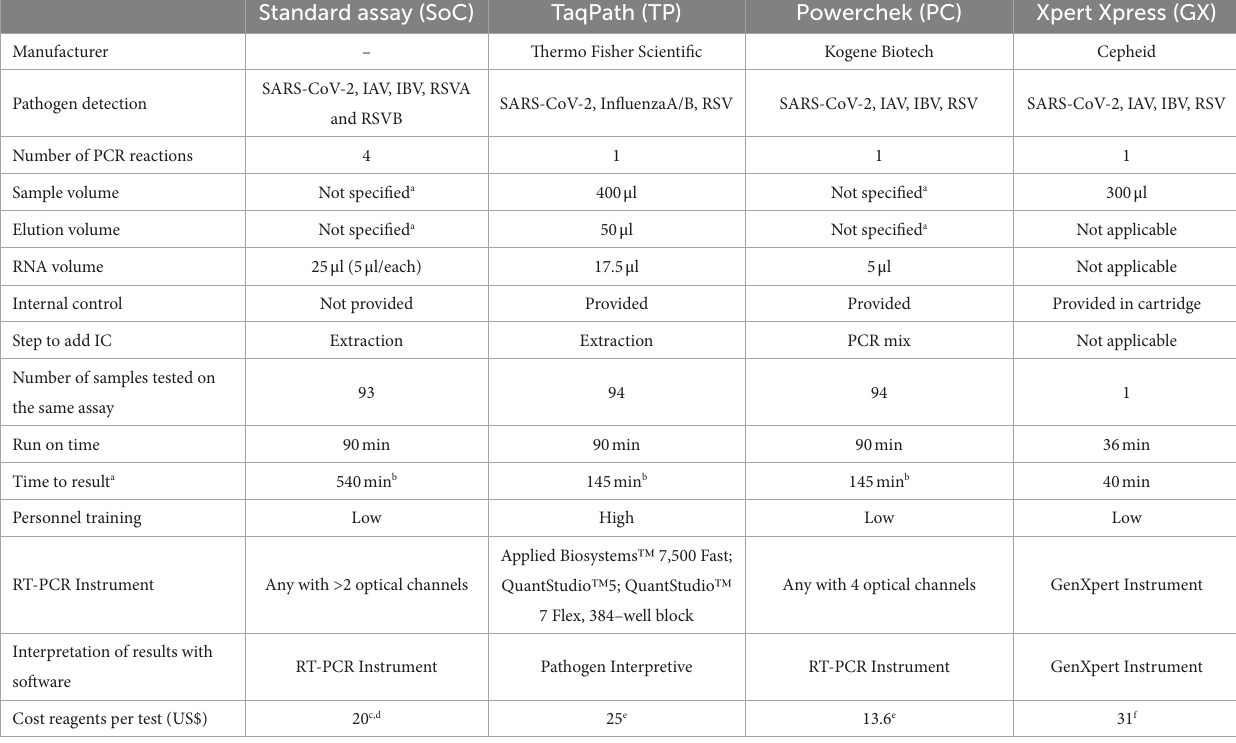
TABLE 4 Comparison of multiplex assays with regards to test specifications, costs and